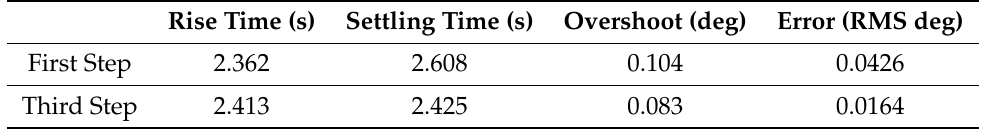
Table 2. Response performance for the first and third positive 30-degree heading